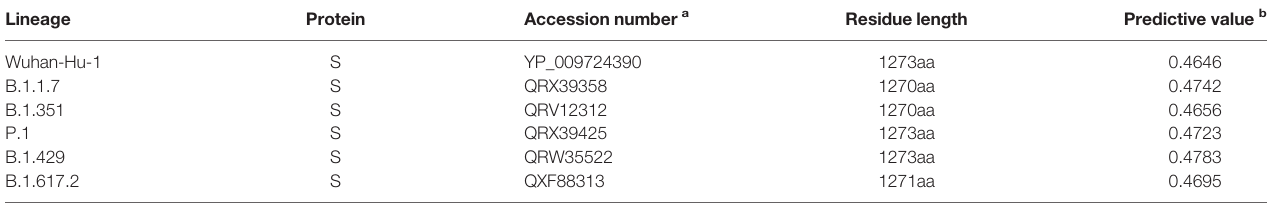
TABLE 1 | The antigenic value of SARS-CoV-2 S proteins. Lineage